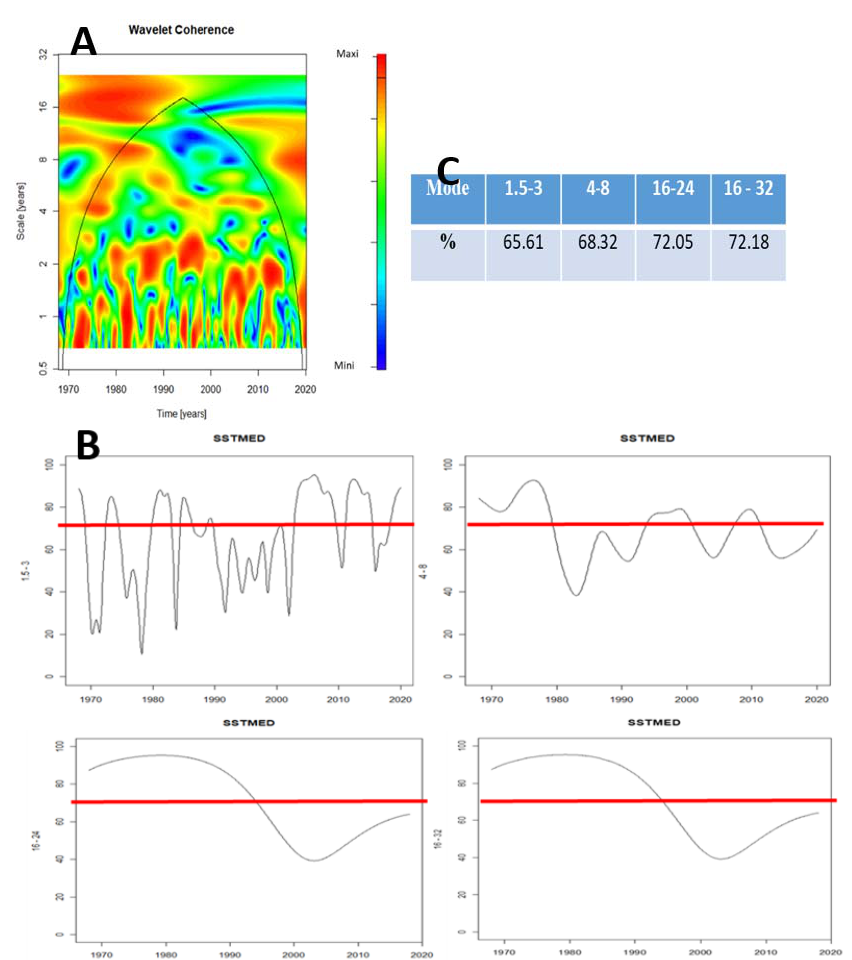
Figure 8. ( A )—Wavelet correlation between regional monthly average precipitation and the Mediter- ranean Sea Surface Temperature (SSTMED). ( B )—Wavelet correlation between regional monthly average precipitation and the Mediterranean Sea surface temperature (SSTMED) depending on the various modes of variability. ( C ) – Wavelet correlation between regional precipitation and SSTMED (percentage)